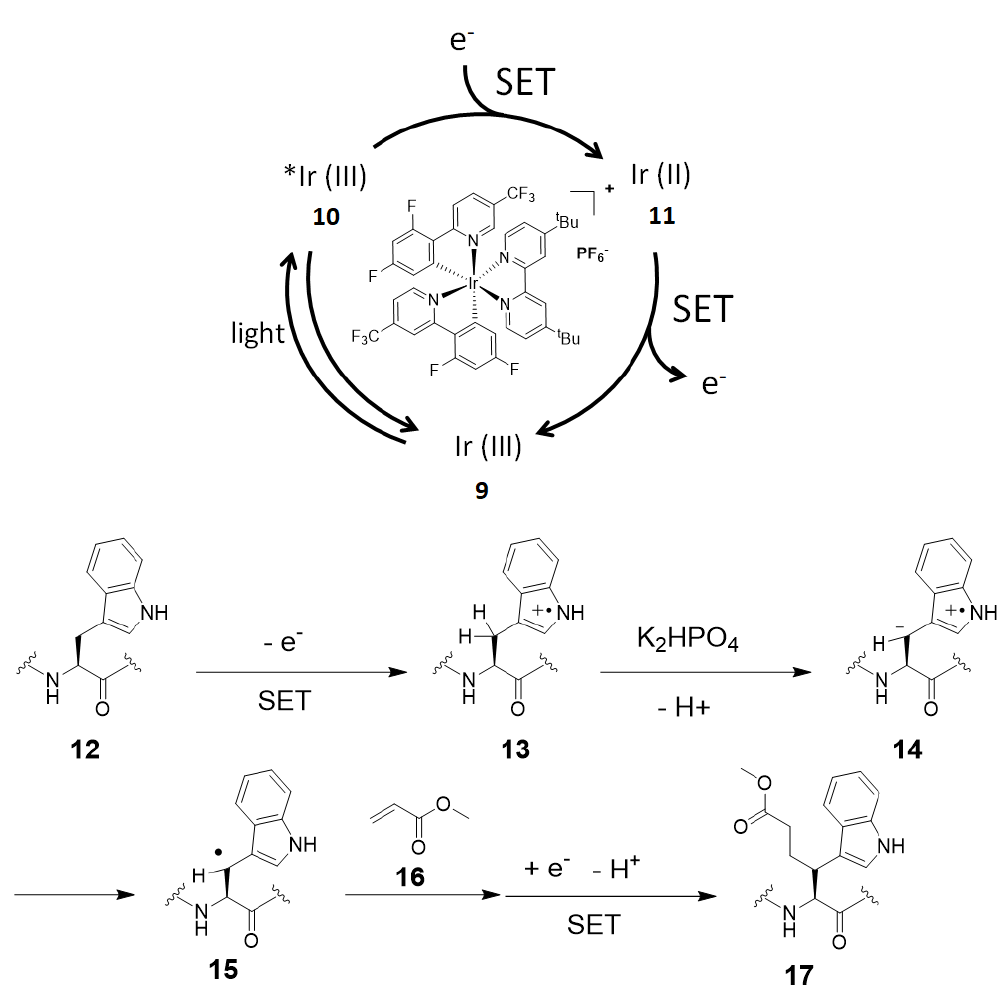
Figure 6. Proposed reaction mechanism for tryptophan β -position labeling with iridium photocatalyst.